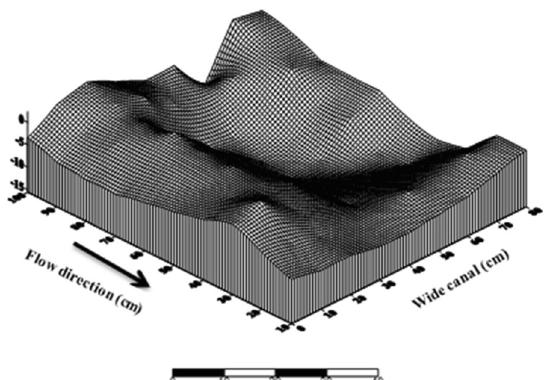
Fig. 5 3D model of bed channel downstream sharp-crested weir at apron solid 50-cm length, 25-cm weir height, and discharge 25